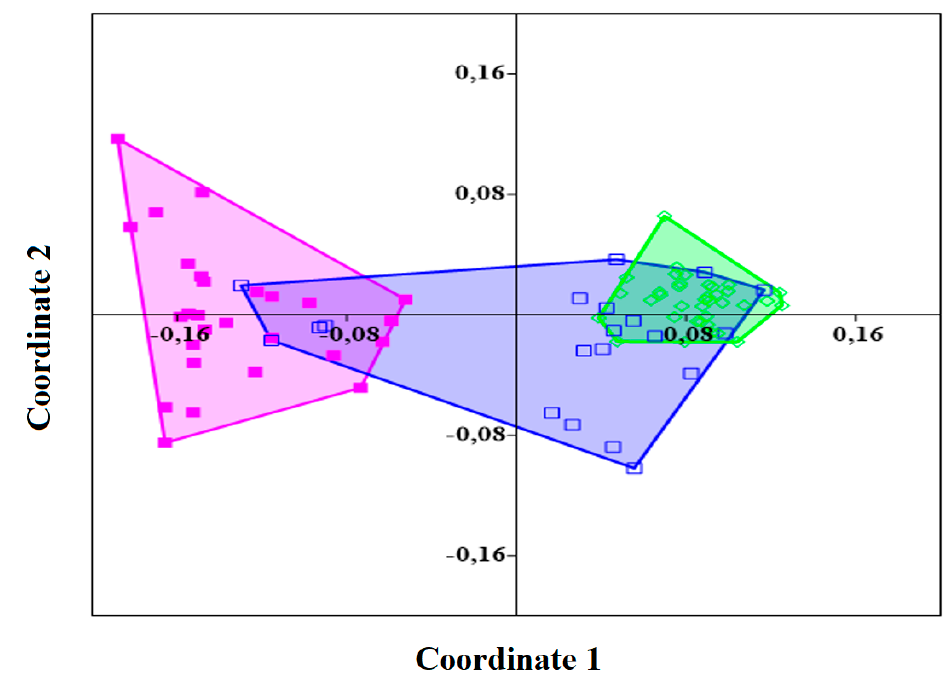
Figure 4. Nonmetric multidimensional scaling based on Euclidean distances was used (the n–MDS) for land use structure. Painted squares represent data set for agricultural land, open squares represent sets of points related to forests and diamonds are the designation for the meadows (stress = 0.23).